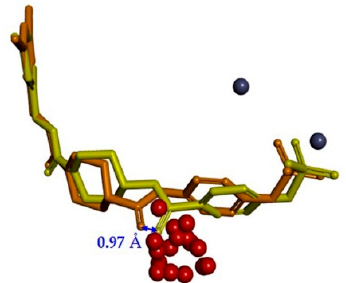
Figure 4. Comparison of the binding modes of compound 1 (orange stick model) and compound 2 (yellow stick model). The distance between CO groups of compound 1 and compound 2 was found to be 0.97 Å. The CO group of compound 2 was located closer to the L’ region. The centers of mass of water networks and zinc atoms are represented by red and dark blue spheres, respectively.